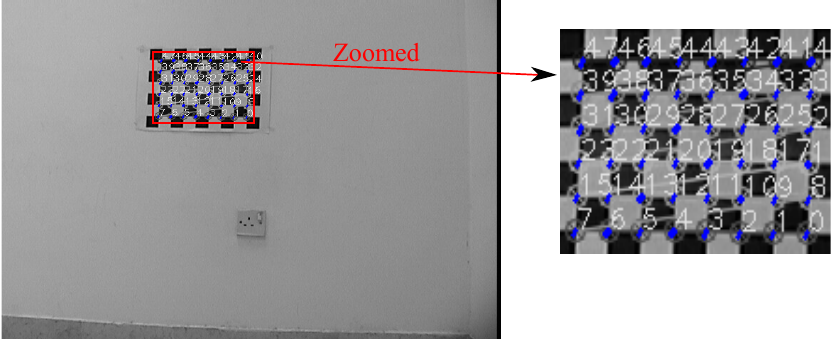
Figure 11. Configuration 2: Reprojection error based on the estimated X and Z matrices. Blue lines indicate the amount of the reprojection error (original image resolution 704 × 480).